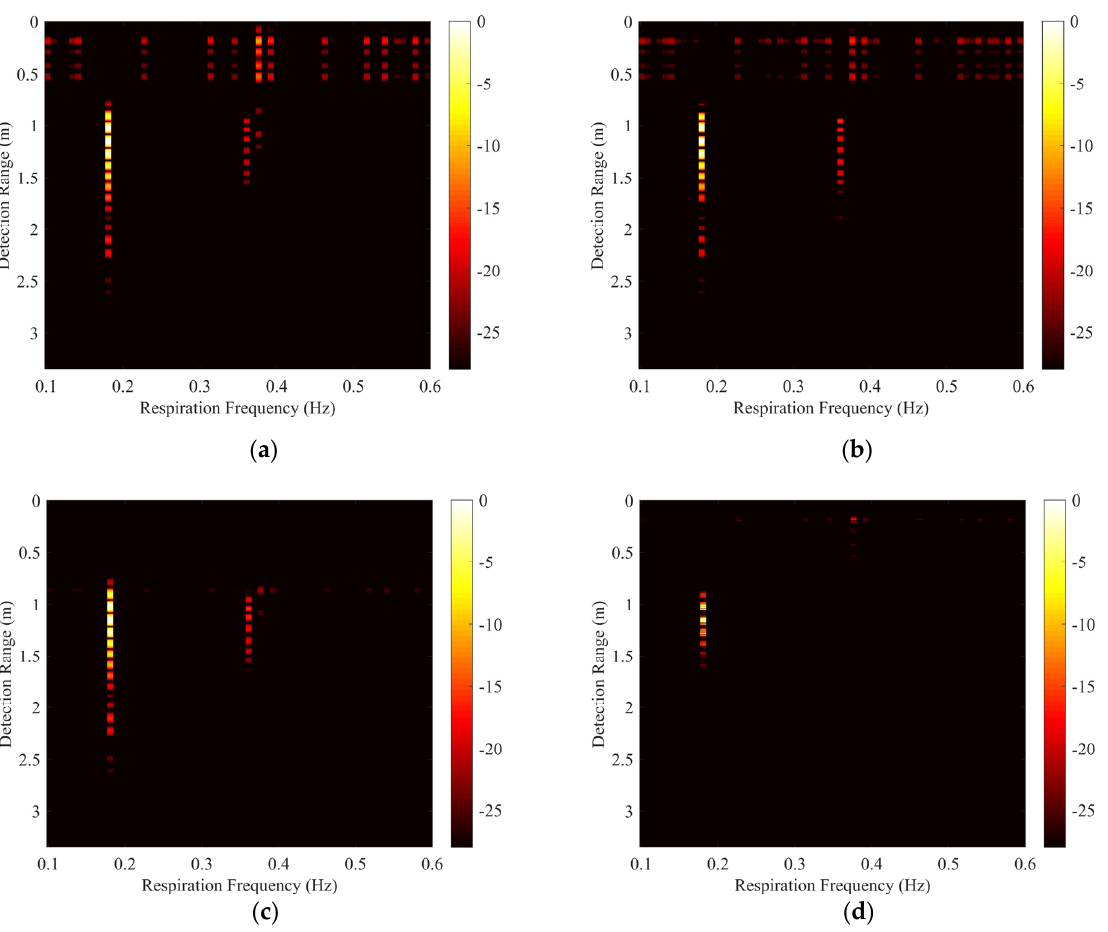
Figure 6. Results for the simulated data processed by different methods. ( a ) The result processed by mean subtraction (MS), ( b ) the result processed by singular value decomposition (SVD), ( c ) the result processed by the method in [36], and ( d ) the result processed by our method, where λ = 10.